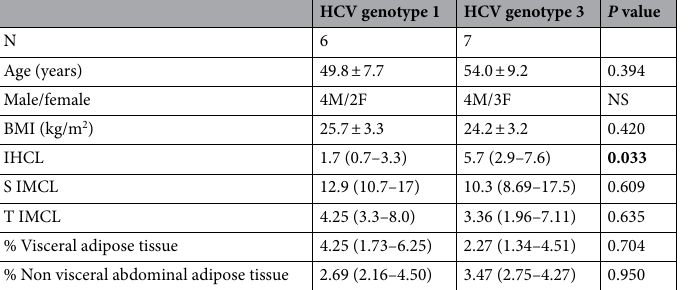
% Visceral adipose